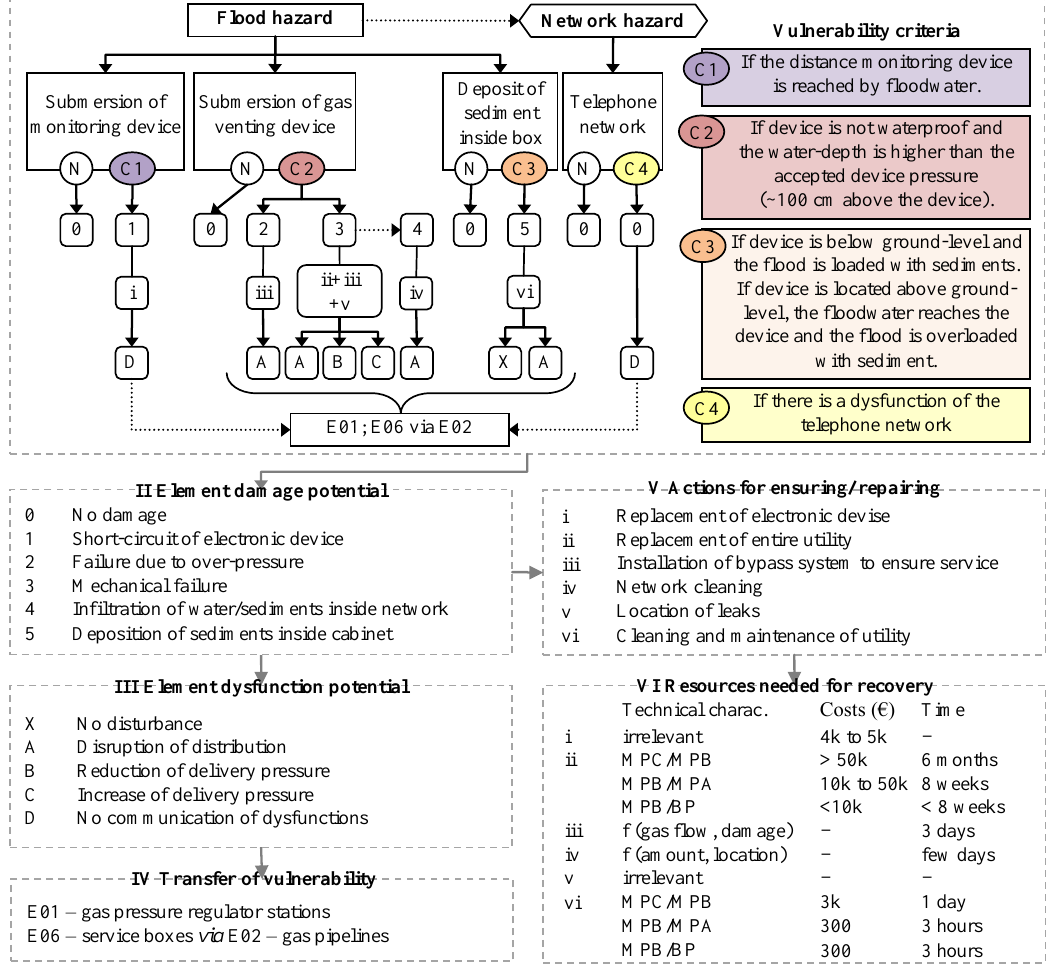
Figure 4. Damage-dysfunction matrix - pressure regulator station of the gas distribution network. 2 Fig. 4. Damage-dysfunction matrix – pressure regulator station of the gas distribution